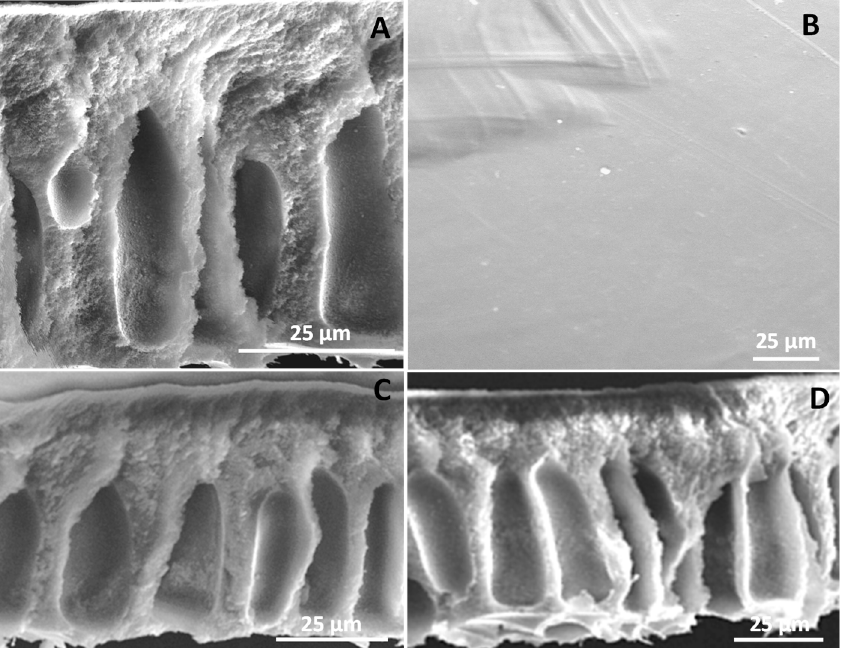
Figure 6. SEM images of mixed-matrix membranes (MMMs) fabricated: ( A ) cross-section of MMM containing Cu(II)BTC, ( B ) top surface of MMM containing Cu(II)BTC, ( C ) cross-section of MMM containing Cu(I/II)BTC, and ( D ) cross-section of MMM containing Cu(I)EDS. All membranes were